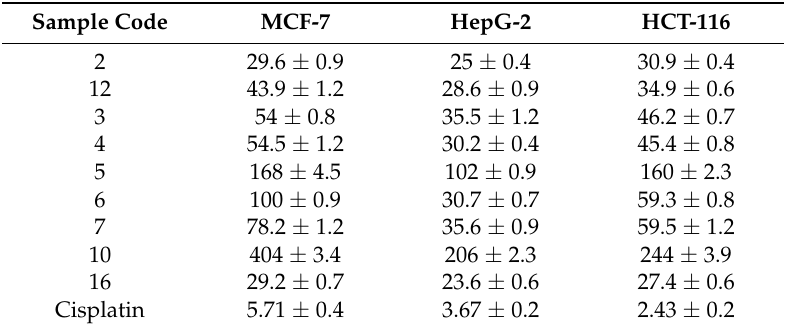
Table 1. The anti-tumor activities of the tested compounds expressed as IC 50 values and compared with reference standard drugs evaluated on breast cancer and liver cancer cell